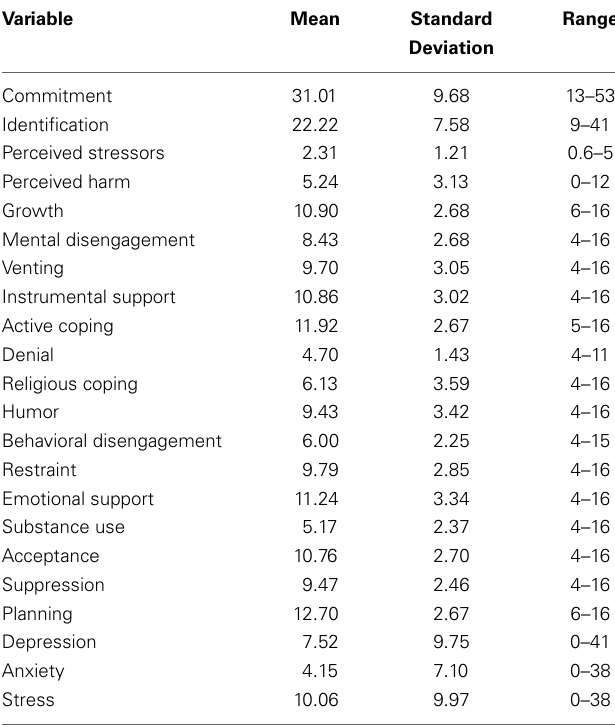
Table 4 | Means and standard deviations for commitment, identification, perceived stressors and harm, COPE and DASS variables for the Part 2